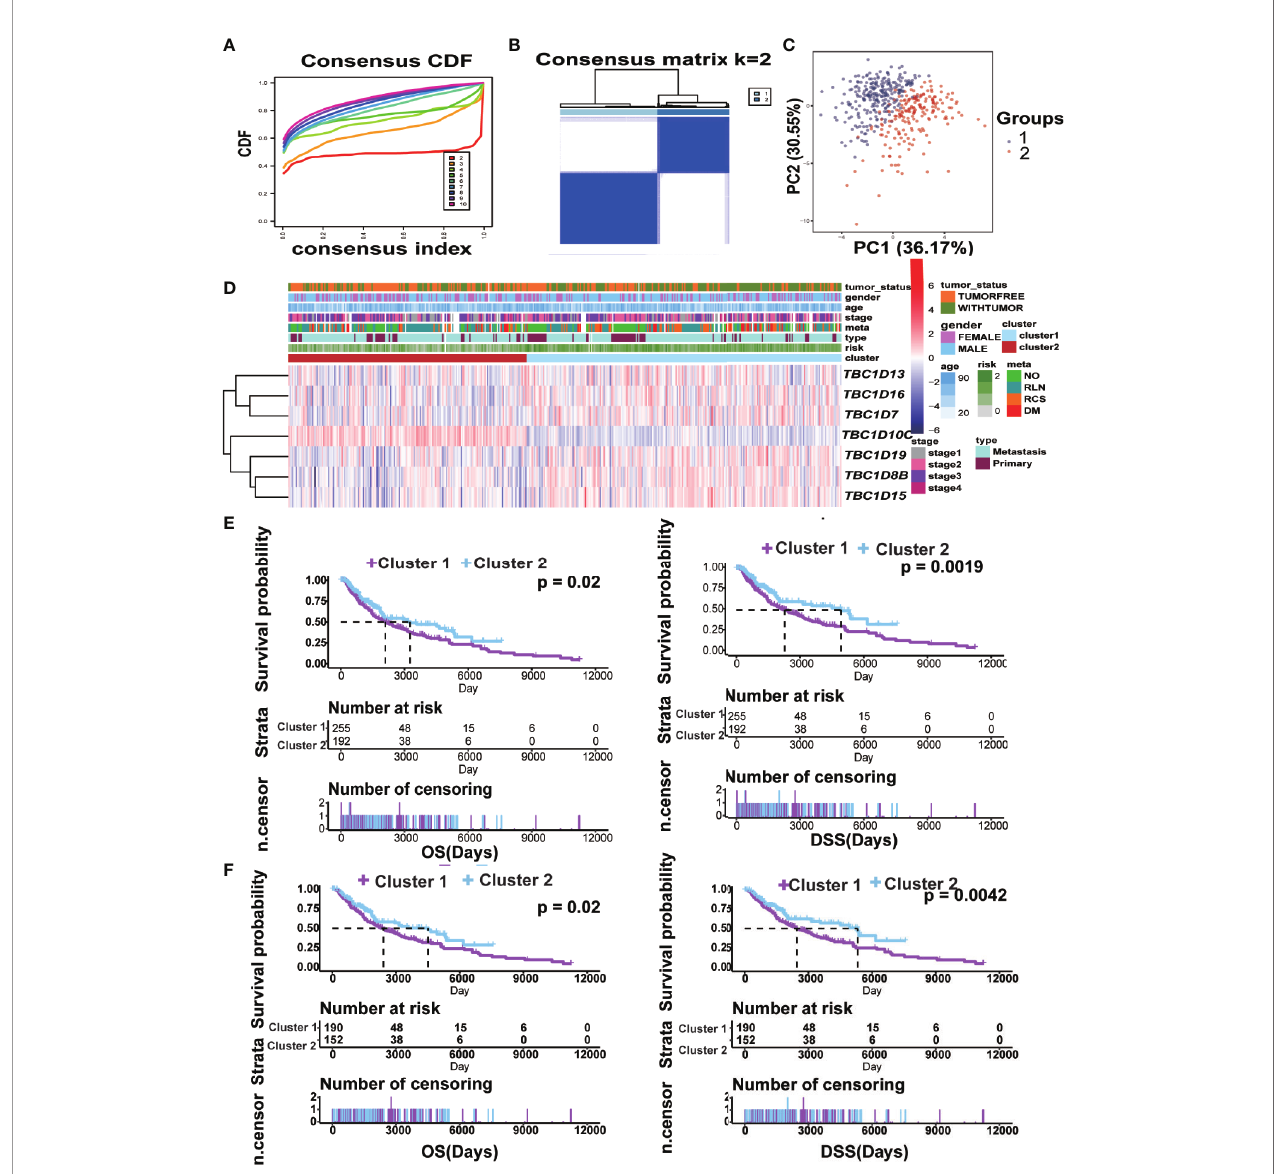
FIGURE 6 | Construction of cluster model and the clinical characteristics and survival analysis based on clusters. (A) Clustering by the consensus clustering algorithm with k= 2 to 10. The cumulative distribution function (CDF) plot of the TBCs mRNA expression in melanoma from TCGA. k=2 was de fi ned as the optimal number. (B) Consensus matrix for 2 clusters. The dark blue rectangles show the samples assigned to the 2 clusters while the light blue lines represent the unassigned samples. (C) The distributions of clinical features and the seven prognostic associated TBCs expression according to the clusters (cluster 1 vs cluster 2) in TCGA are showed by heat maps. (D) Comparisons of risk score values between subgroups separated by clinicopathological characteristics. Kaplan ± Meier survival analyses demonstrated the differences in OS and DSS based on clusters (cluster 1 vs cluster 2) in tumor tissues (E) and Metastasis tissues (F) from